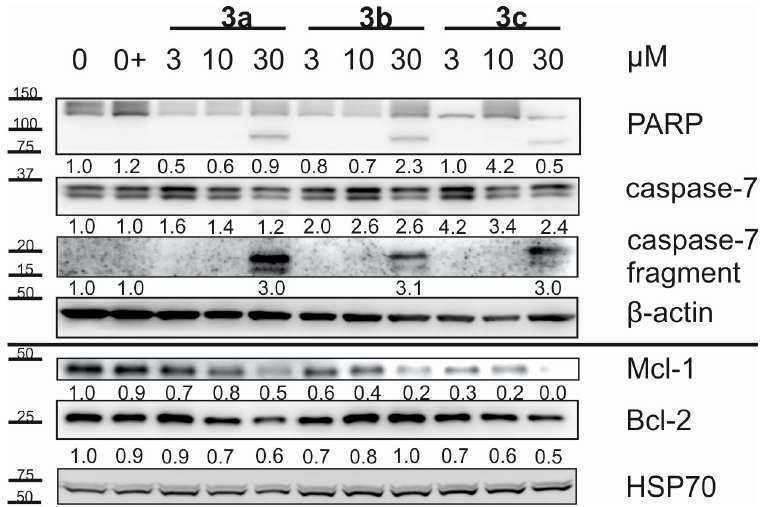
Figure 2. The level of protein markers of apoptosis. The level of protein markers of apoptosis (PARP, caspase-7 zymogen and fragment, Mcl-1, Bcl-2) detected by Western blotting. β -Actin or HSP70 was used as loading control. HeLa cells were treated for 24 h with 3a – 3c (3, 10 and 30 µM). The bars 0 are control untreated cells, the bars 0+ are control cells with DMSO. The results presented here are based on the representative experiment repeated three times. All data were analyzed by statistical software. Signal intensities of bands were quantified by MultiGauge software (FujiFilm) and normalized to loading ( β -actin or HSP70). The quantification is presented as the number below each band (x-times).